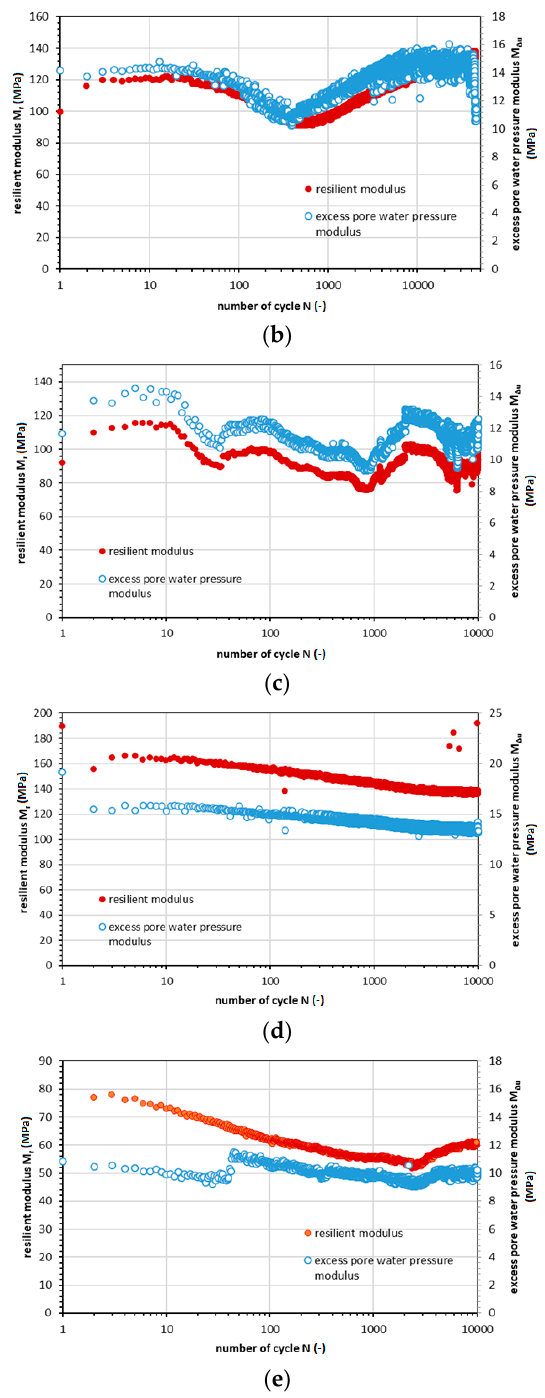
Figure 13. Resilient modulus and excess pore water pressure modulus change during the cyclic loading for K 0 consolidated samples: ( a ) σ ’ 3,0 = 65.0 kPa, ( b ) σ ’ 3,0 = 125.0 kPa ( c ) σ ’ 3,0 = 139.7 kPa, ( d ) σ ’ 3,0 = 94.2 kPa, and ( e ) σ ’ 3,0 = 44.9 kPa.